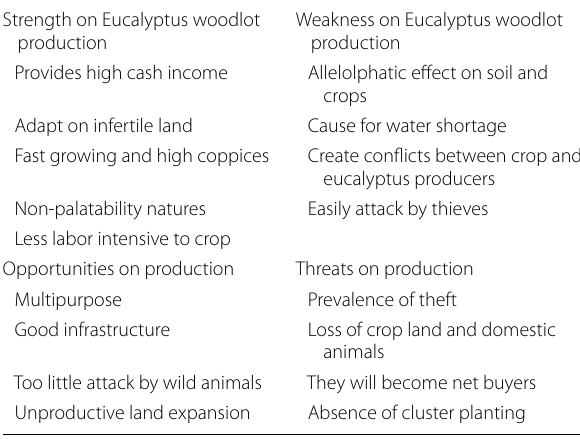
Table 5 SWOT analysis matrix of woodlot production Strength on Eucalyptus woodlot